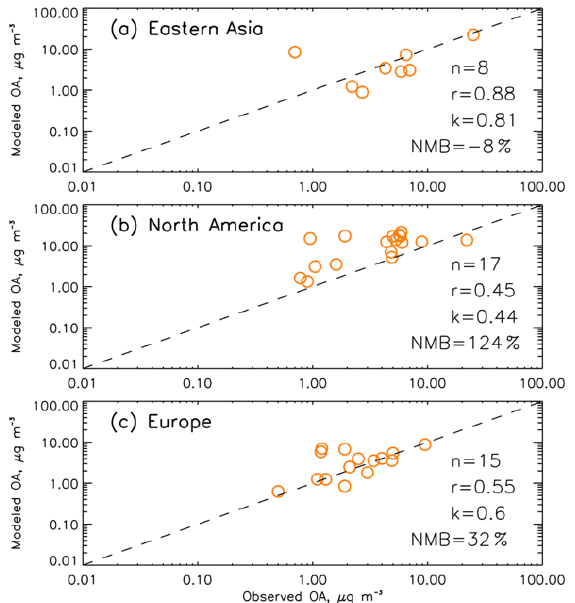
Figure 2. Comparisons of observational and model-simulated sur- face OA concentrations from (a) eastern Asia, (b) North America and (c) Europe. For each panel, the total number of observational sites ( n ), model–observation regression slopes ( k ), correlation coef- ficient ( r ) and NMB values are included. The dashed line in each panel represents the 1 : 1 ratio.